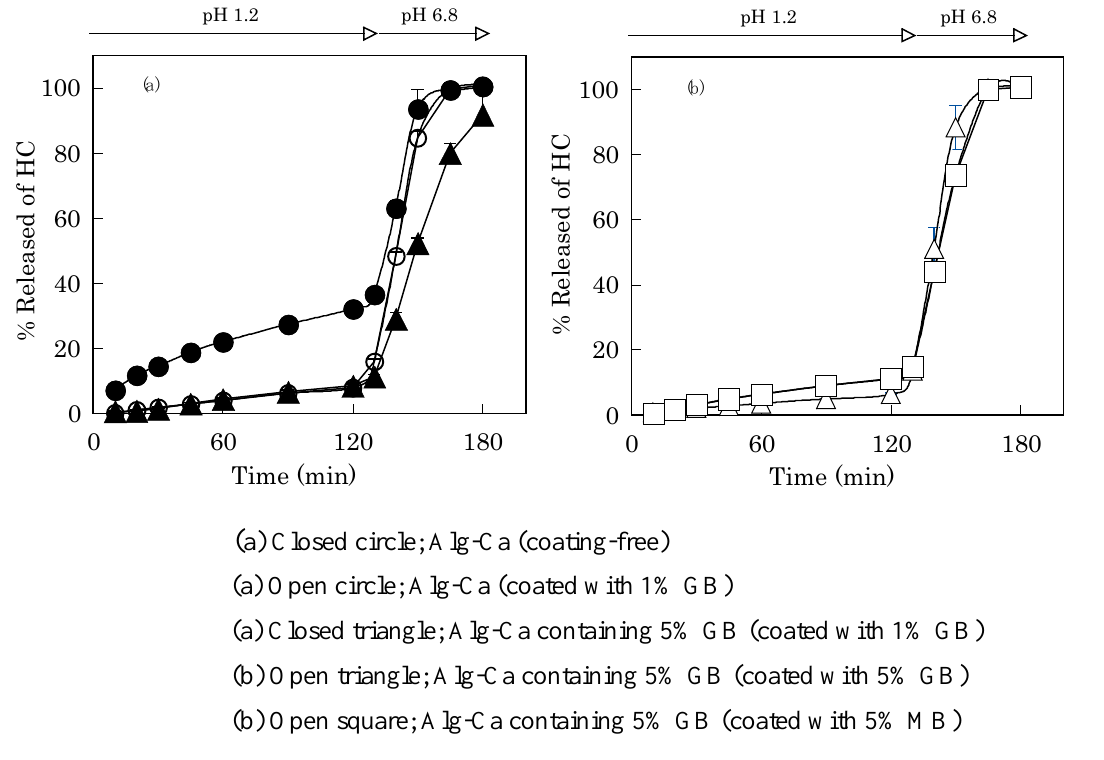
Figure 4. HC-Release curves from Alg-Ca prepared with 0.1 M CaCl